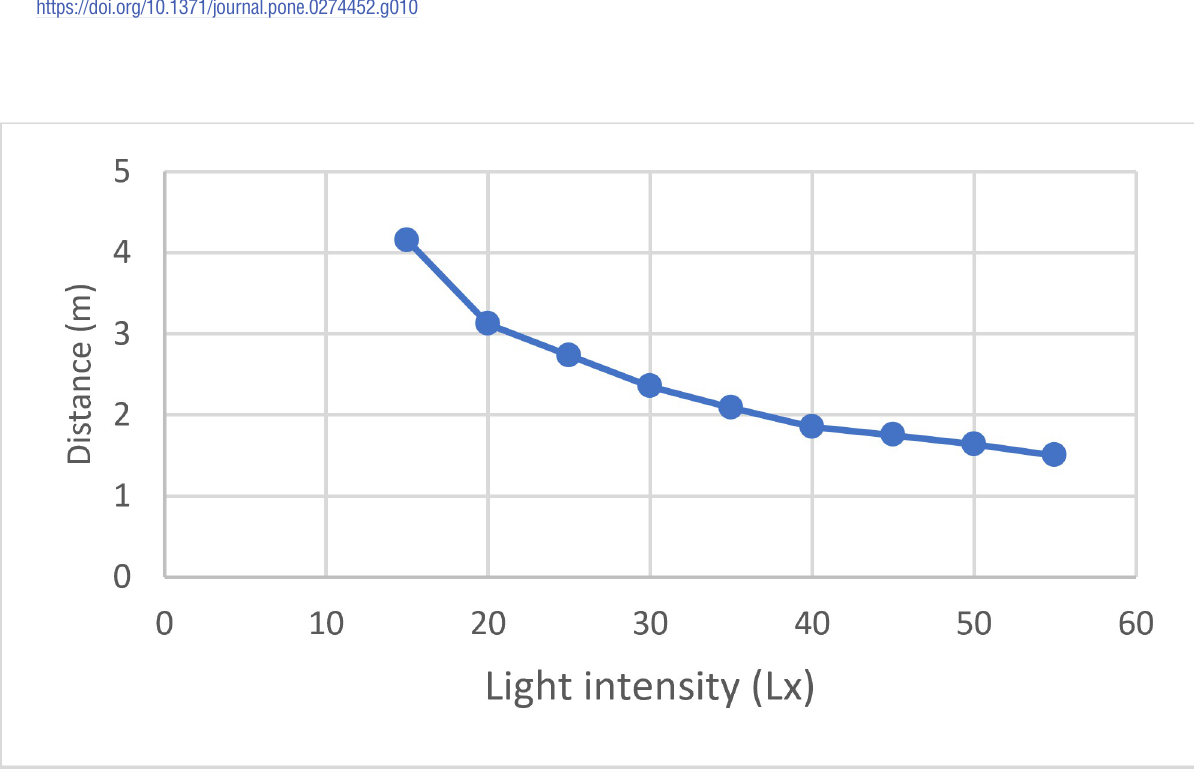
PLOS ONE | https://doi.org/10.1371/journal.pone.0274452 September 29,